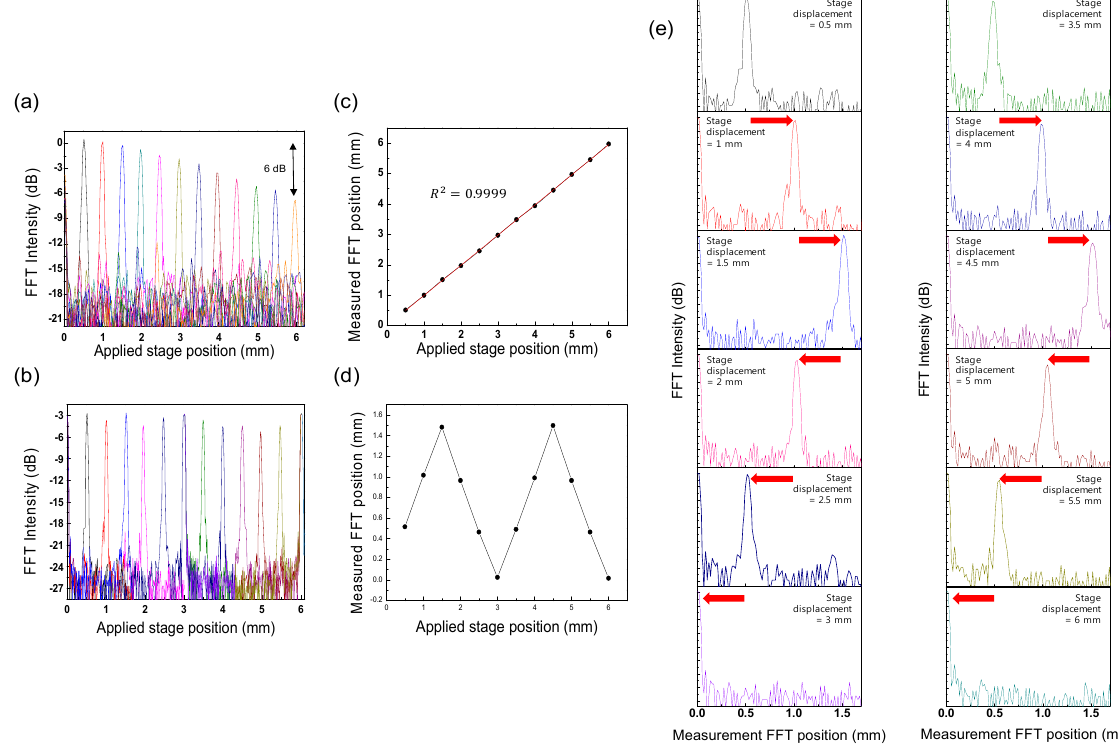
Figure 6. Results obtained when the stage displacement changes from 0.5 to 6 mm. ( a ) Trace of the FFT intensity of the conventional WSL as a function of the applied stage position; ( b ) Trace of the FFT intensity of the proposed WCSL for the applied stage position; ( c ) The relation between the applied stage position and measured FFT position of the conventional WSL; ( d ) The relation between the applied stage position and measured FFT position of the proposed WCSL; ( e ) Trace of the FFT intensity of the proposed WCSL for the measured FFT position.